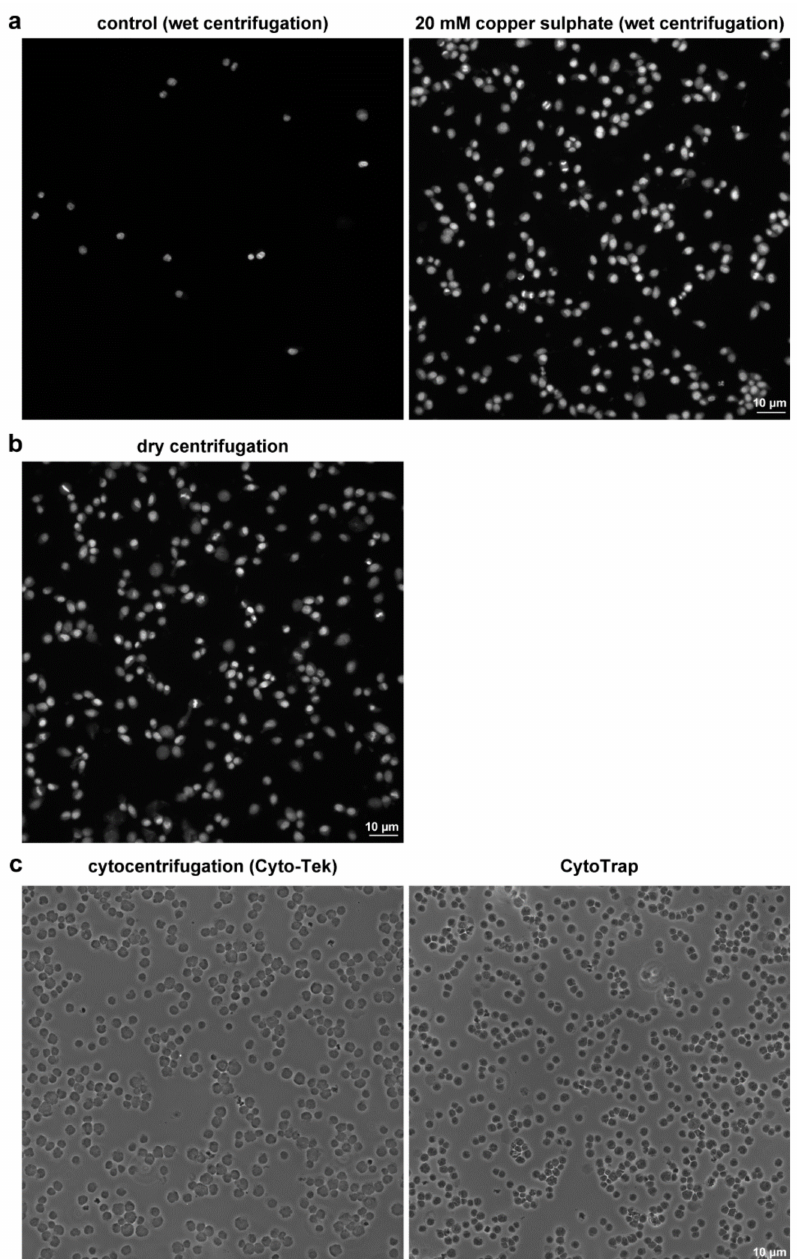
Figure 5. Comparison of the capture efficiency. ( a ) Comparison of the capture efficiency in samples of HeLa S3 cells prepared with the wet centrifugation and fixed by formaldehyde solution without (left) or with (right) the additional incubation of samples in the 20 mM copper sulphate solution. The whole procedure including DAPI staining was done in CytoTrap. ( b ) Example of the capture efficiency in samples processed by dry centrifugation and formaldehyde fixation. The whole procedure including DAPI staining was done in CytoTrap. The same cell concentration of the cell suspension was used in 5a and 5b. ( c ) Comparison of the samples prepared by conventional cytocentrifuge (left) and by CytoTrap (right). The same cell concentration of the cell suspension was used in both cases. Scale bar = 10 µ